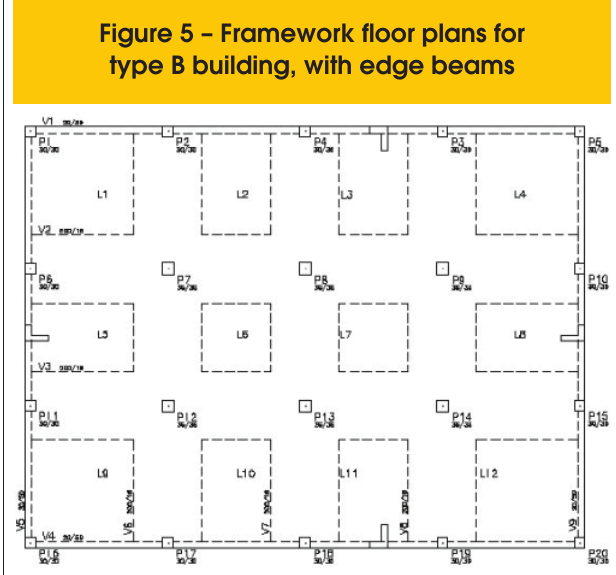
Figure 5 – Framework floor plans for type B building, with edge